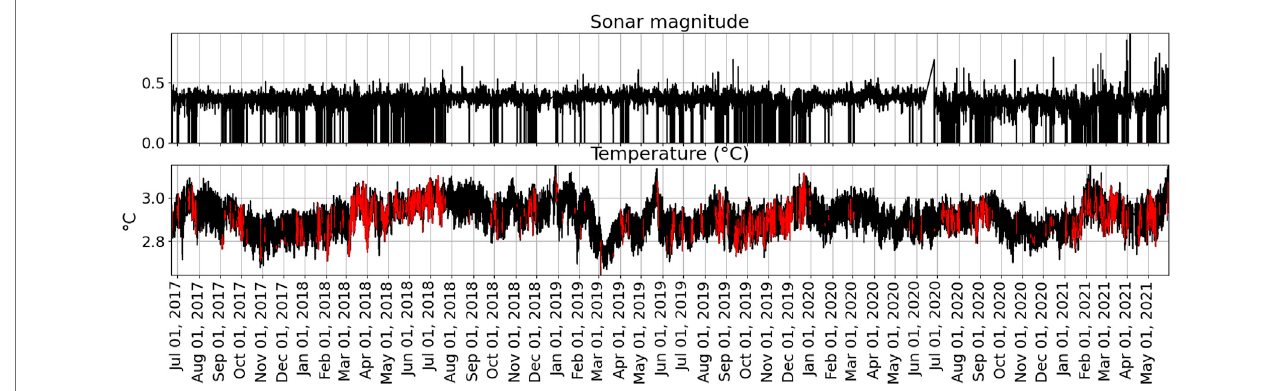
FIGURE 9 | Sonar magnitude and bottom temperature. The red color indicates times of vent inactivity. Magnitude data are dimensionless.